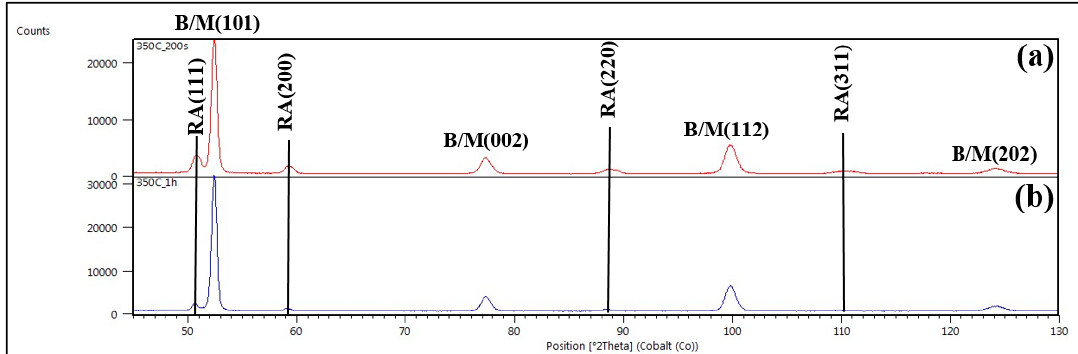
Figure 10. The XRD patterns of Q&B samples isothermally heat-treated at 350 °C for: ( a ) 200 s; and ( b ) 1h. The locations of FCC retained austenite (RA) peaks are highlighted with solid lines, while the BCC bainite / martensite indices are shown with B / M symbols, respectively.